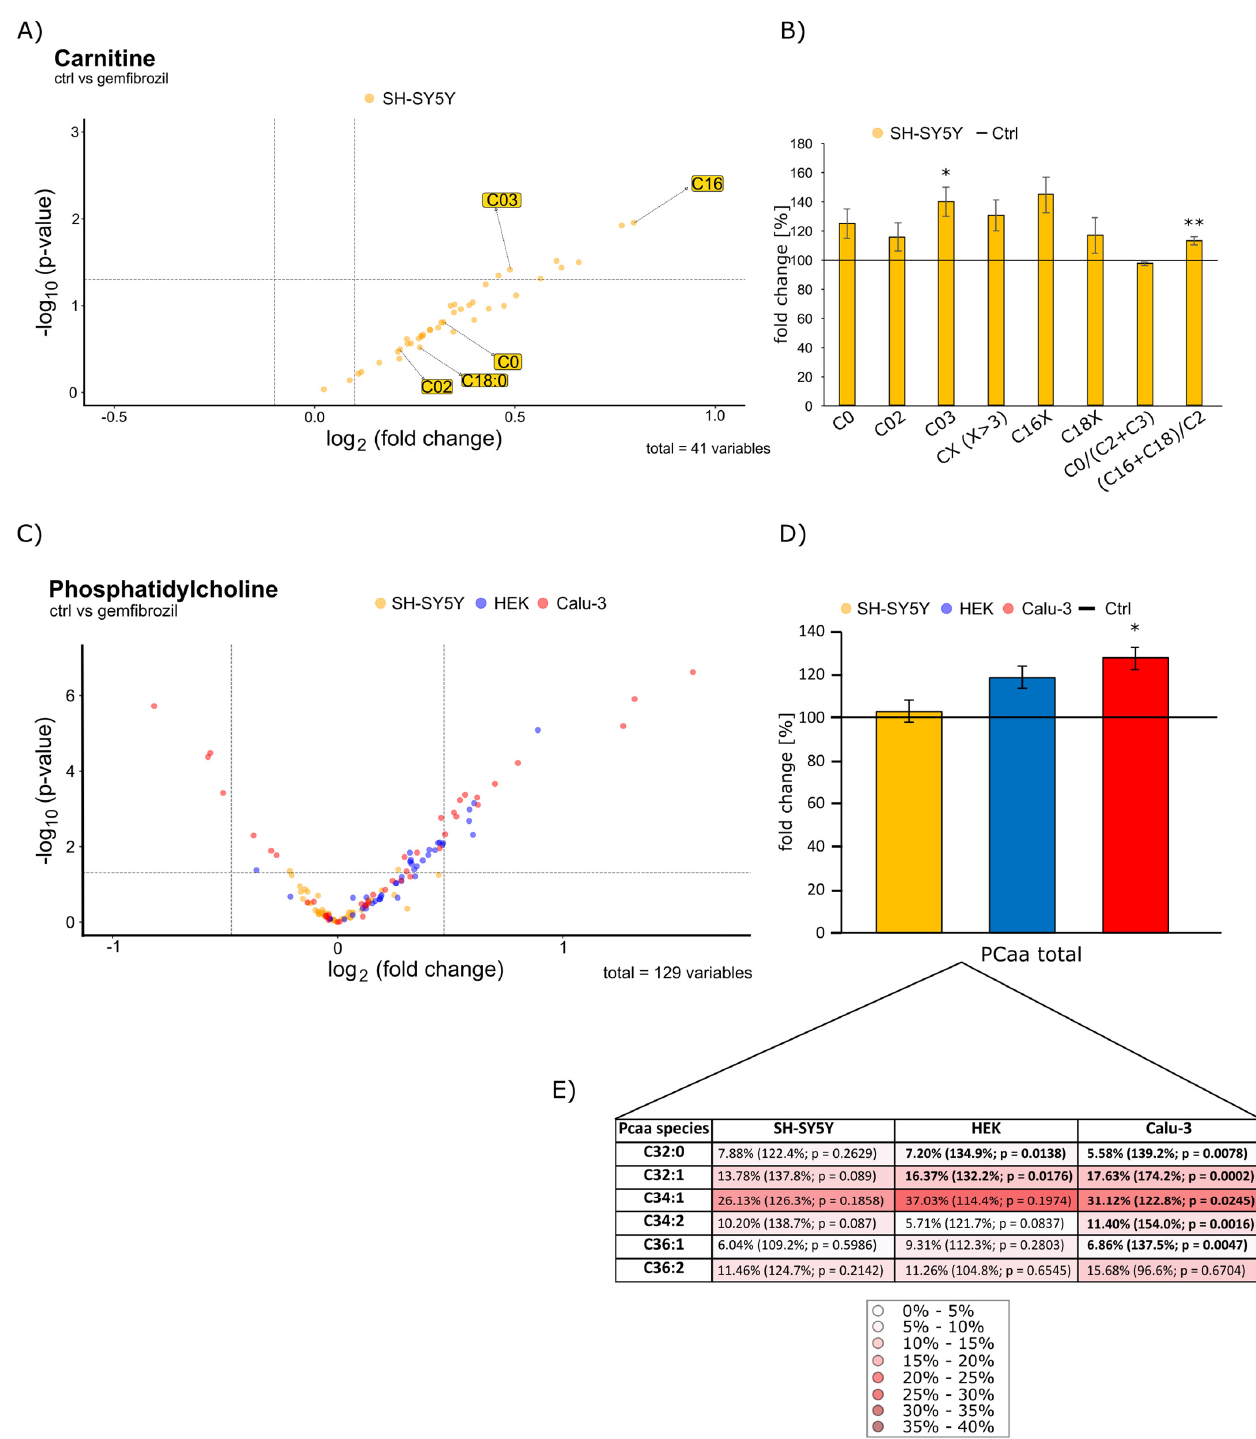
Figure 2. ( A ) Changed carnitine levels in SH-SY5Y cells after Gemfibrozil treatment compared to cells treated with the solvent control (ethanol) are illustrated in the volcano plot, where the fold